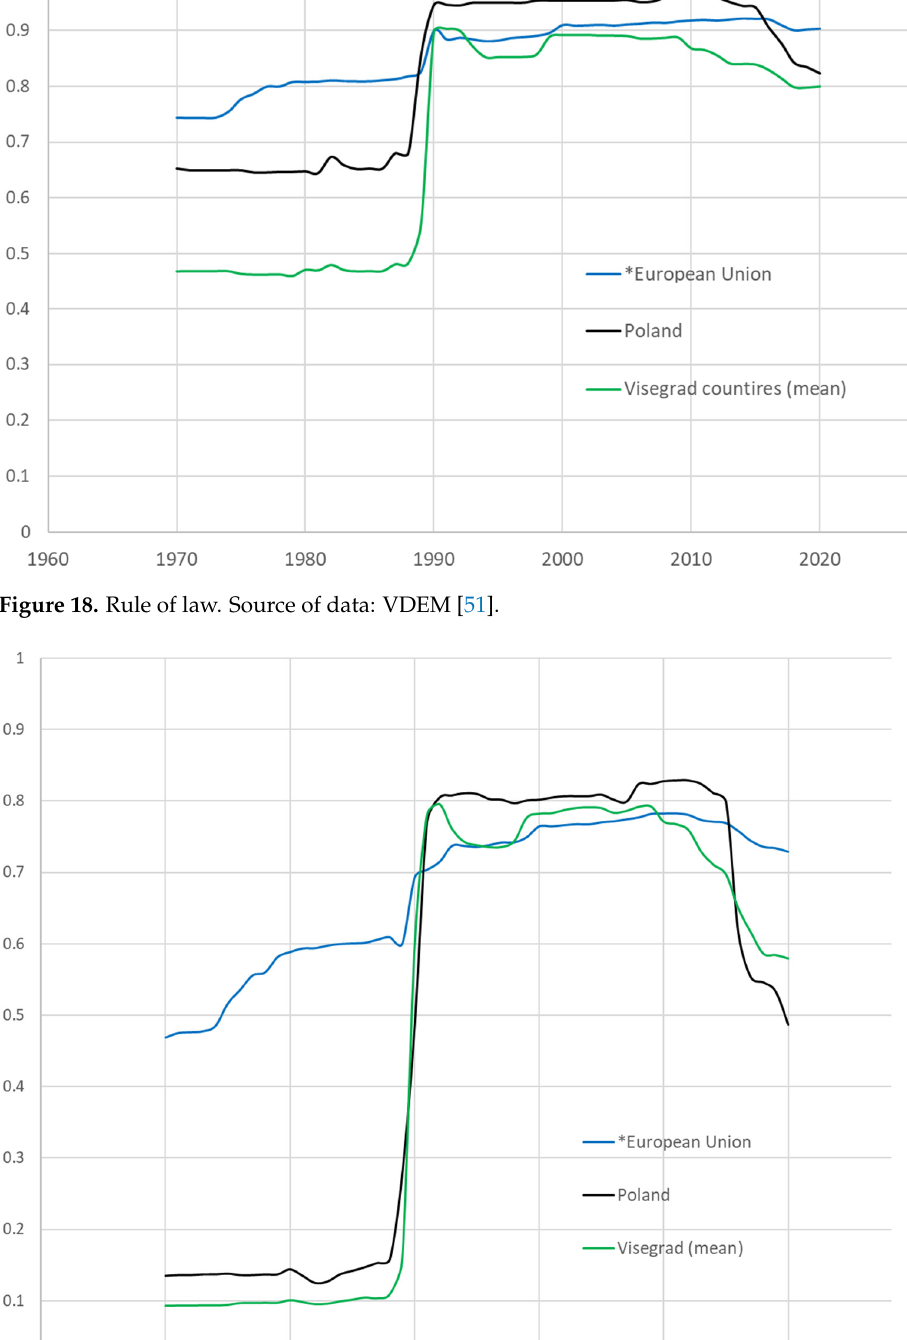
Figure 20. Confidence in institutions. Source of data: WVS [50].